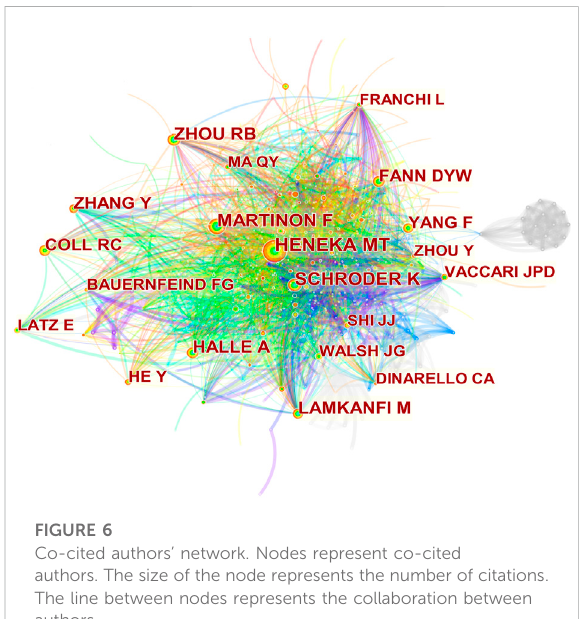
FIGURE 6 Co-cited authors ’ network. Nodes represent co-cited authors. The size of the node represents the number of citations. The line between nodes represents the collaboration between authors.